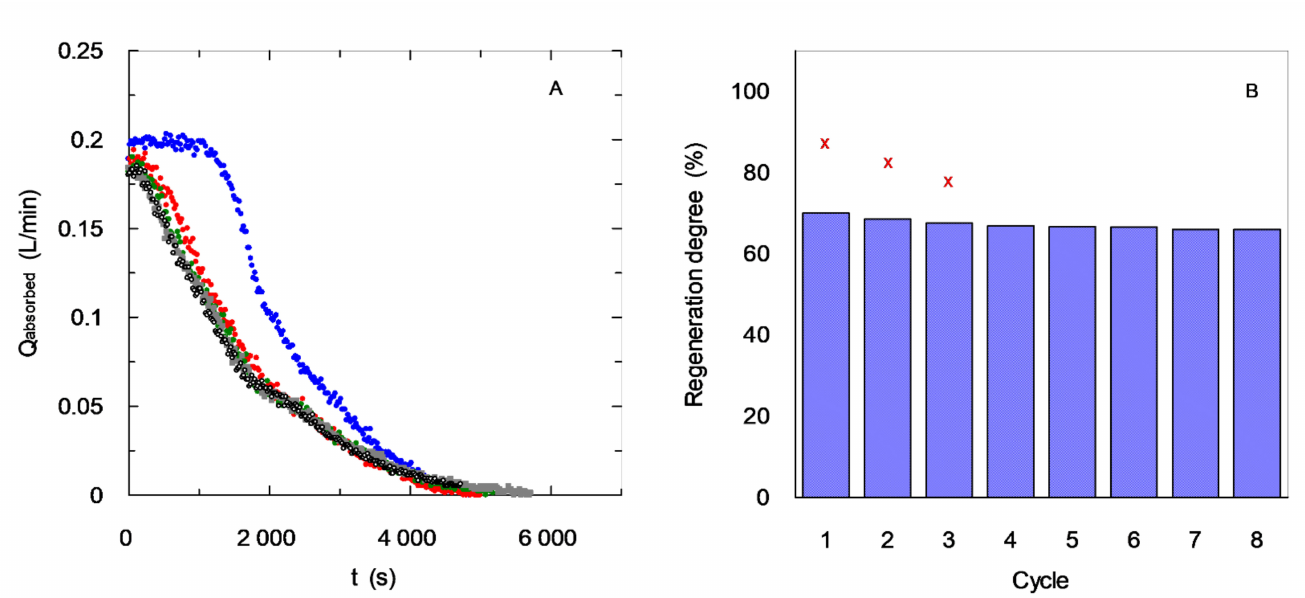
Figure 9. Influence of absorption/regeneration cycles upon absorption curve ( A ) and regeneration degree ( B ) using EDA-based chemical solvent. C B = 0.6 mol · L − 1 . Q G = 0.2 L · min − 1 . Fresh solvent; 1st cycle; 3rd cycle; 5th cycle; 7th cycle. (x) MEA solvent [37] C B = 0.3 mol·L − 1 . Q G = 0.3 L·min − 1 .